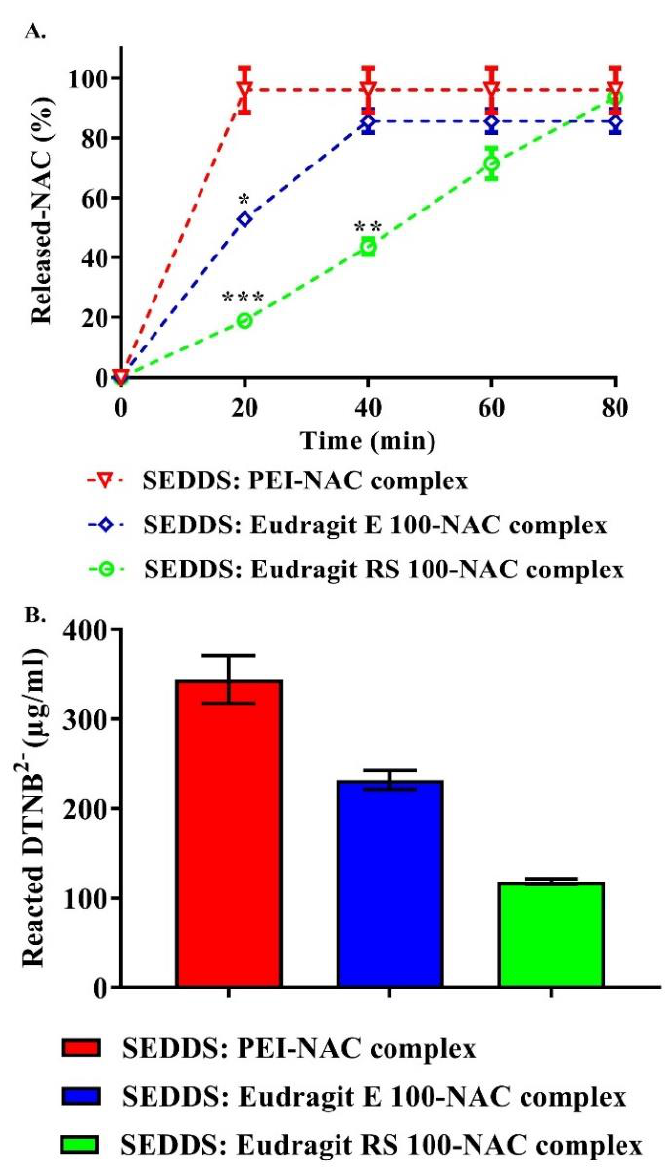
from PEI’s, Eudragit E 100’s, and Eudragit RS 100’s SEDDS complexes, respectively. Only Figure 7. The partition coefficients log P n-octanol/water and log D SEDDS/release medium were determined at 37 by releasing NAC with a sulfhydryl group having a pKa of 9.8 [12] can a new disulfide °C in relation to free NAC as well as NAC complexes with PEI, Eudragit E 100, and Eudragit RS 100 heterodimer of DTNB 2 − be formed [21]. Based on the obtained NAC release profiles, by measuring their solubility from the diluted organic phases of n-octanol and SEDDSs and aqueous NAC that was released from SEDDSs at optimum level effectively underwent disulfide– phases of demineralized water and release medium in 0.05% DTNB 2− containing 0.5 M Ellman’s exchange reaction with DTNB 2 − and caused considerable yellow staining in the release buffer (pH 8) using 450 nm absorption wavelength. In comparison to free NAC, *** p ≤ 0.001 and ** medium. Provided that optimum NAC reactivity was attained from the release studies, the p ≤ 0.01 were found. The values given are the means ± standard deviations ( n ≥ 3). likewise disulfide–exchange interactions between the released NAC and mucus-cysteine subdomains could also predict significance.